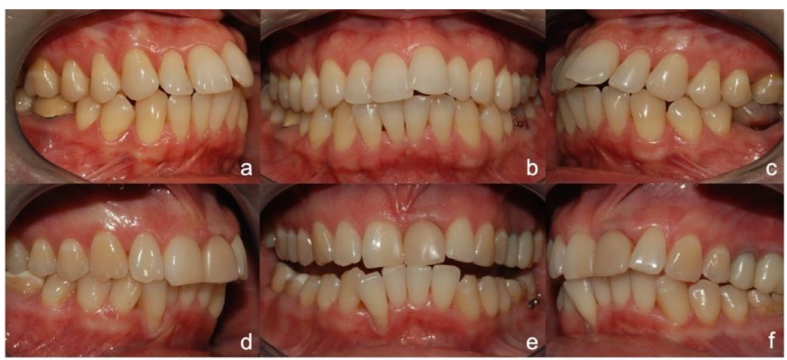
Figure 3. Biotype assessment from the digital photographs. ( a – c )—thin biotype was recorded when triangular crowns and interproximal contacts close to the incisal edge were present; and the contours of tooth roots and the capillary network were easily visible; ( d – f )—thick/normal biotype was recorded when square-shaped tooth crowns and long interproximal contact located more apically were present; and the contours of tooth roots and the capillary network were not